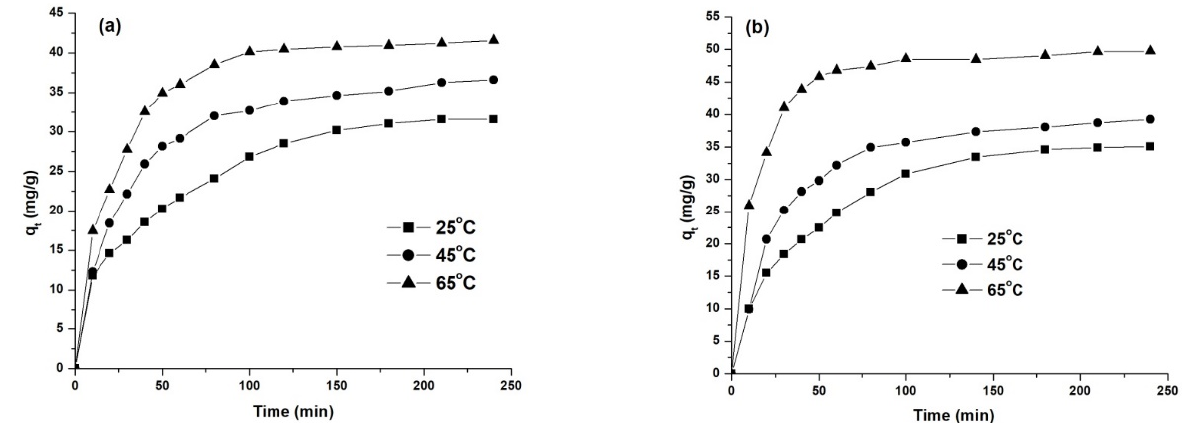
Figure 11. Effect of temperature on dye removal capacity: AY 42 ( a ) and AR 213 ( b ); 1 g/L PM4, 25 °C, natural pH of solution.